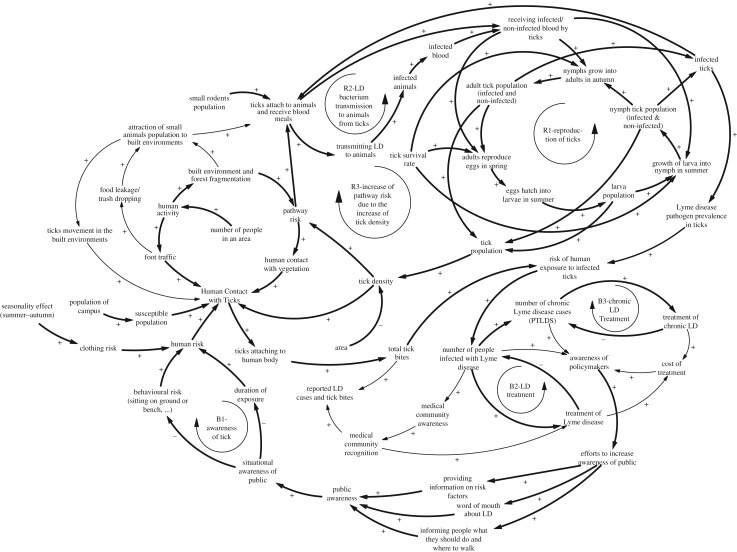
Causal loop diagram.